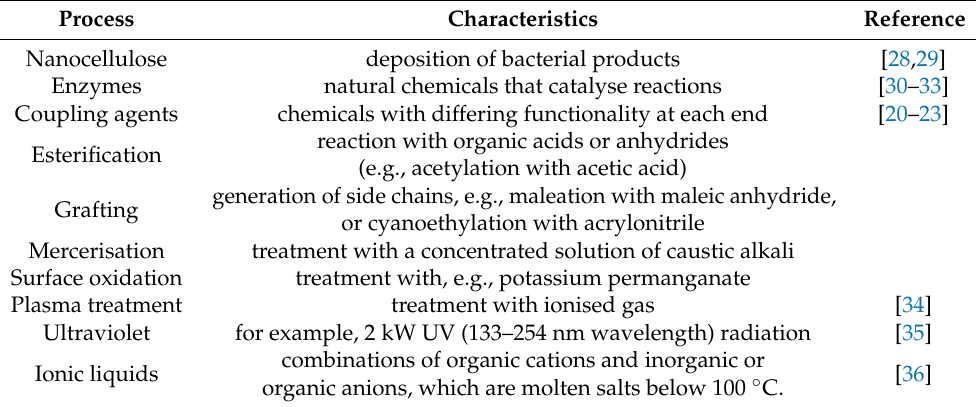
Table 1. Pretreatment process to enhance interfacial adhesion between the reinforcement fibre and the matrix